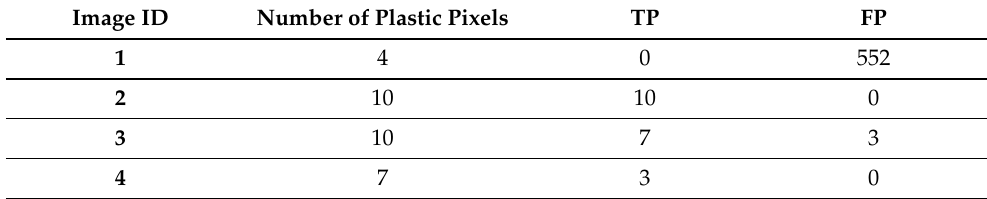
Figure 11. The predictions of the classifier on S2 real images. S2 images presented in Table 3 are displayed on the first row for band B02. Second row present the predictions obtained by the classifier. When there are two patches on the image, the top one is plastic and the bottom one is wood. (For interpretation of the references to color in this figure legend, the reader is referred to the web version of this article.) Table 4. Table with the true and false positive numbers for each S2